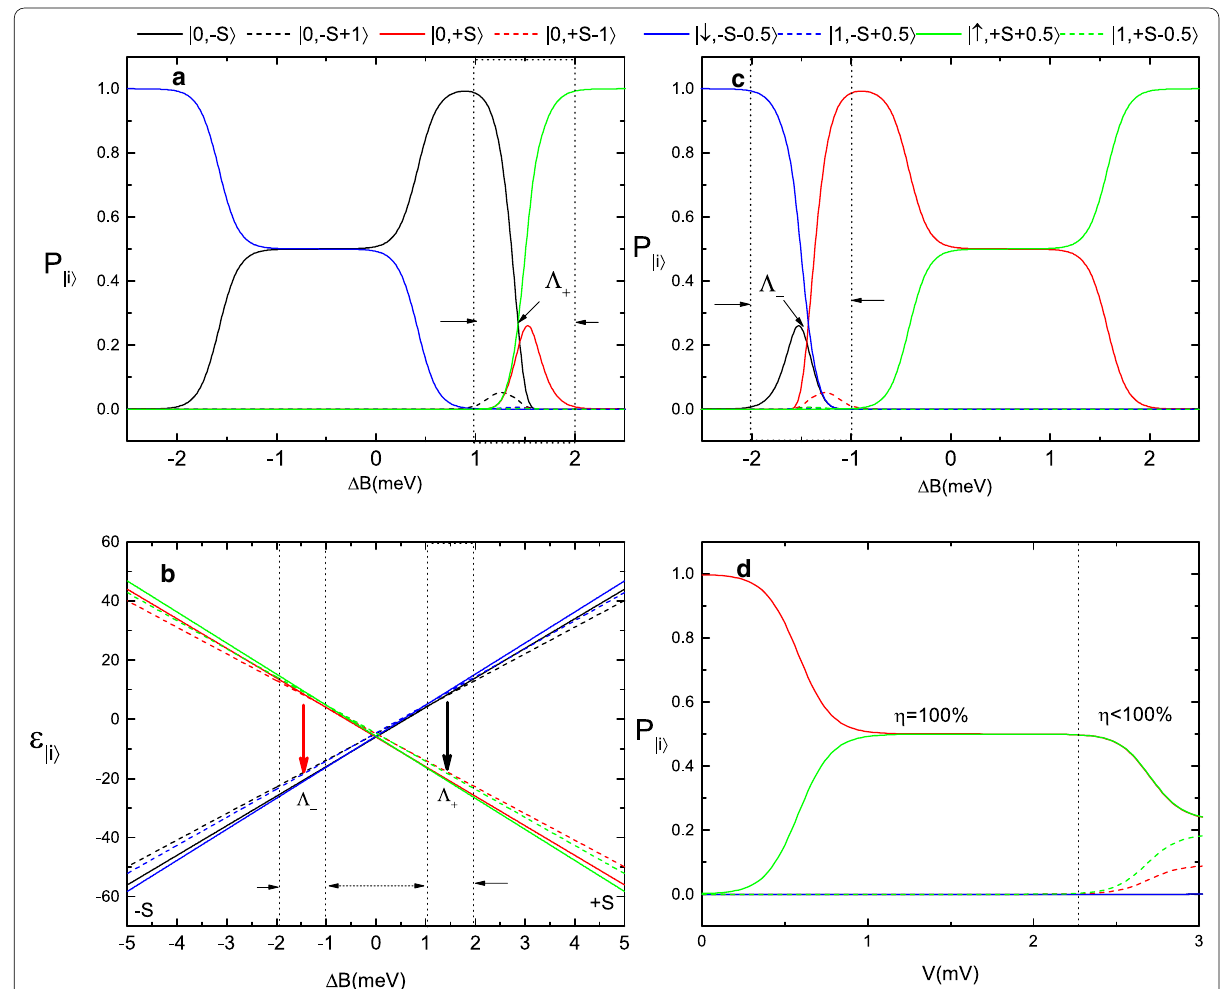
Fig. 4 a , c Variations in the molecular state probabilities a as (cid:31) B is scanned from − 5 meV to + 5 meV and c as (cid:31) B is scanned from + 5 meV to − 5 meV. b Zeeman diagram for these spin states as (cid:31) B changes from − 5 meV to + 5 meV. d Variations in the molecular state probabilities as functions of the bias voltage when the molecule’s spin state is initially prepared such that P | 0, + S � = 1 and P i =